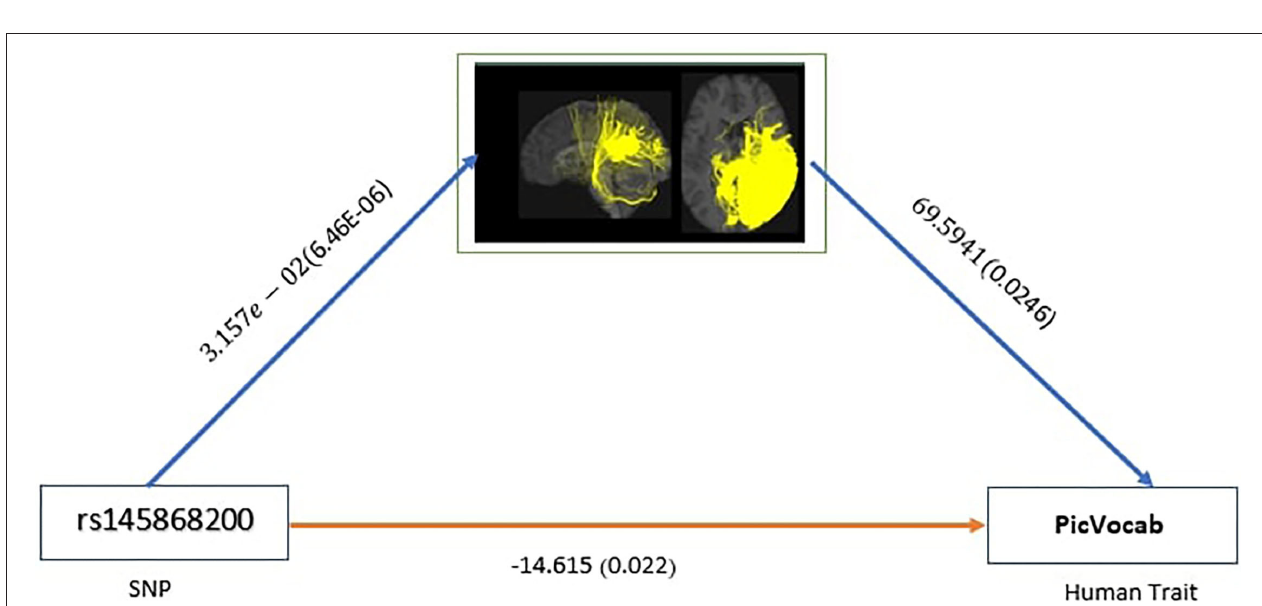
FIGURE 3 | AIE for SNP rs145868200 with significant ADE with p -value<0.05 showing mediation pathways through connectome.